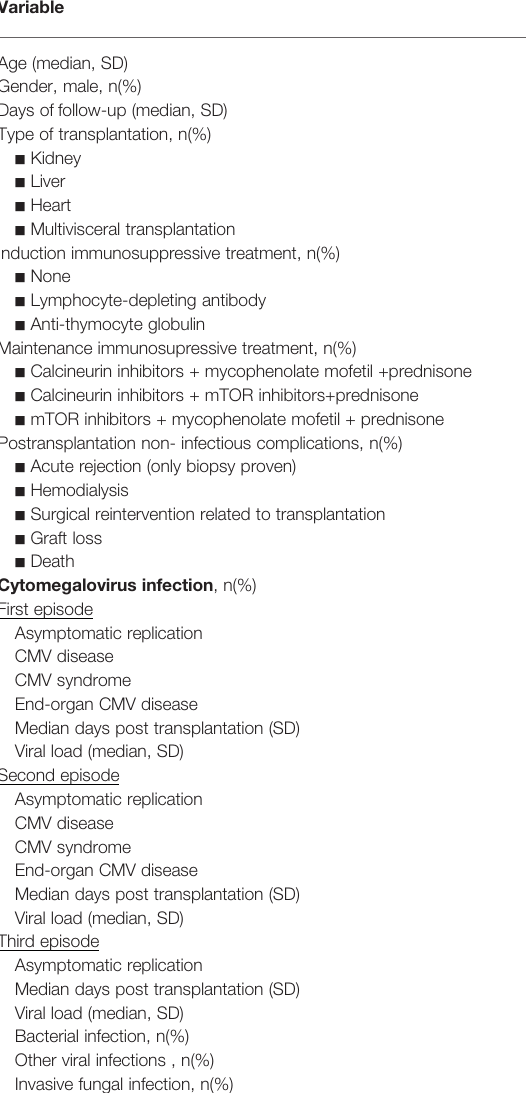
TABLE 1 | Baseline, demographic and clinical characteristics of patients.